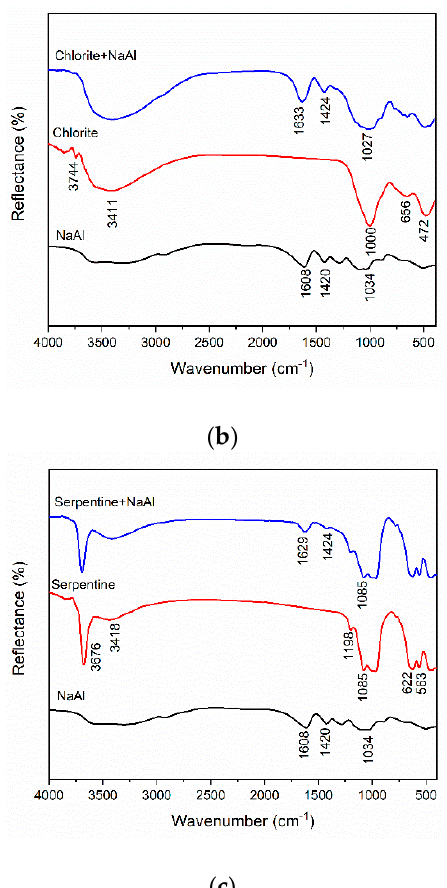
Figure 8. FTIR spectra of chalcopyrite ( a ), chlorite ( b ), and serpentine ( c ) with and without pre-treatment of NaAl.